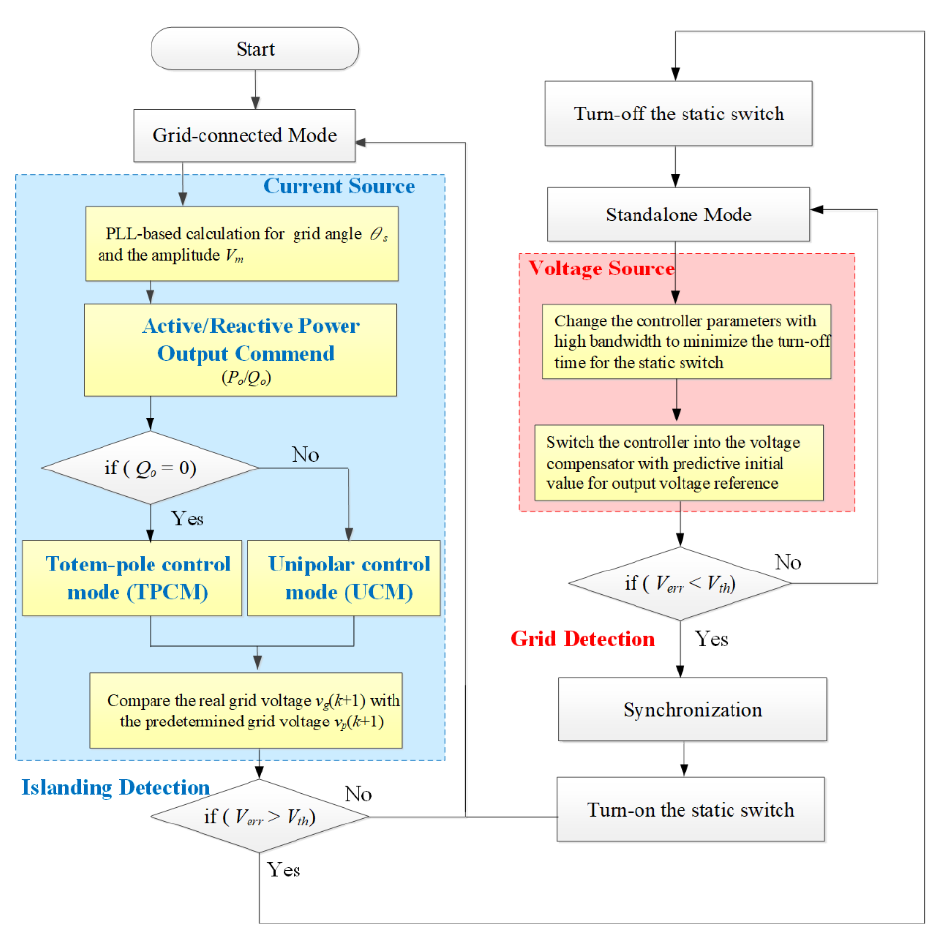
Figure 12. The procedure for the mode transfers between grid-connected mode and standalone mode for the H-bridge inverter.